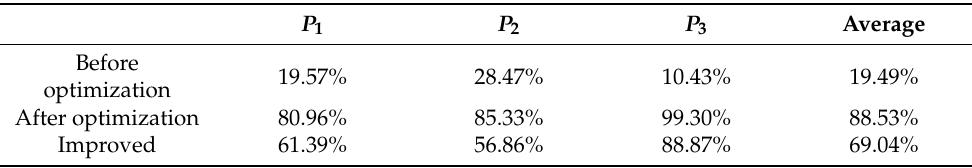
Table 3. Comparison of similarity values before and after